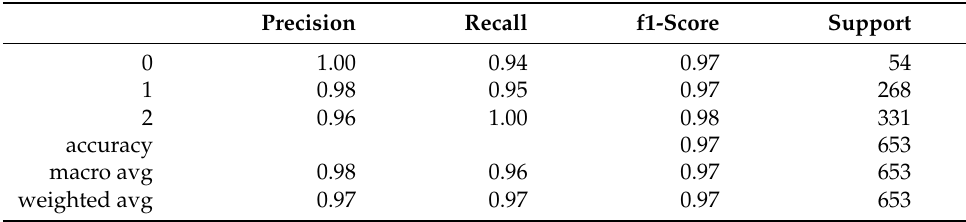
Table 15. Random forest metrics on San Lorenzo test